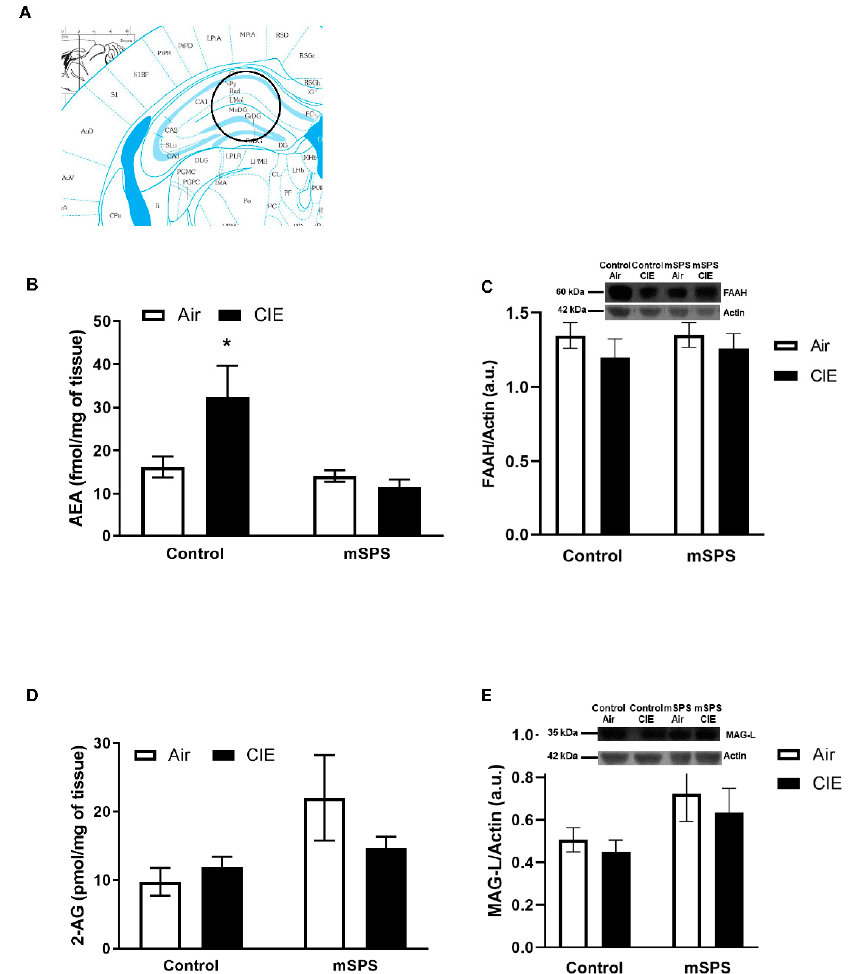
Figure 4. Anandamide (AEA) and 2-arachidonoylglycerol (2-AG) contents, fatty acid amide hydro- lase (FAAH) and monoacylglycerol lipase (MAG-L) levels in the dorsal hippocampus (HC) after mSPS/Control or Air/CIE exposures. ( A ) Schematic of coronal slice where dorsal HC tissue punches were taken bilaterally (adapted from [58]). Average ( B ) AEA content (Control-Air: n = 6; Control CIE: n = 7; mSPS-Air: n = 6; mSPS-CIE: n = 8) increased in Control-CIE mice compared to Control-Air, mSPS-Air, or mSPS-CIE mice after mSPS/Control or Air/CIE exposures (* p < 0.05). However, the average ( C ) FAAH levels (Control-Air: n = 6; Control CIE: n = 4; mSPS-Air: n = 5; mSPS-CIE: n = 8) (Inset: representative immunoblotting sample images) did not change among groups after mSPS/Control or Air/CIE exposures. In addition, average ( D ) 2-AG (Control-Air: n = 6; Control CIE: n = 7; mSPS-Air: n = 6; mSPS-CIE: n = 8) and ( E ) MAG-L levels (Control-Air: n = 6; Control CIE: n = 4; mSPS-Air: n = 5; mSPS-CIE: n = 8) (Inset: representative immunoblotting sample images) did not